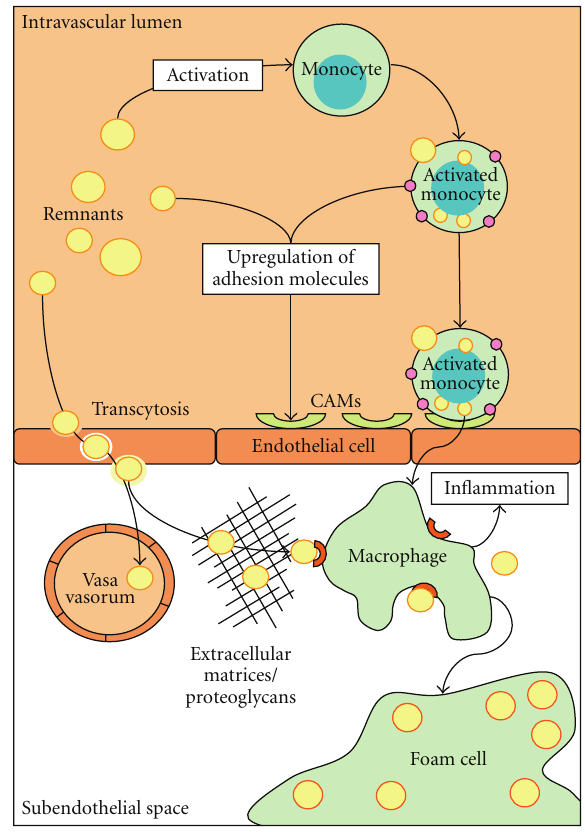
Figure 1: Concept of the initiation of atherosclerosis by rem- nant lipoproteins: remnants enter the subendothelial space via nonspecific transcytotic processes. This is often a nonpathologic process, because the remnants leave the subendothelial space again via the vasa vasorum. However, retention of remnants may occur in the presence of proteoglycans and excess extracellular matrices. Remnants can be easily taken up by macrophages, in contrast to LDL, which need to become modified first. Circulating remnants themselves also contribute to the presence of suben- dothelial macrophages. Monocytes can bind and take up remnants, which stimulates the monocytes to become activated. Subsequently, activated monocytes express adhesion molecules on the outer membrane and stimulate the expression of endothelial cellular adhesion molecules (CAMs), which allows monocytes to home on the endothelium and migrate into the subendothelial space. Finally, the macrophages change into highly atherogenic foam cells when lipid uptake exceeds lipid e ffl